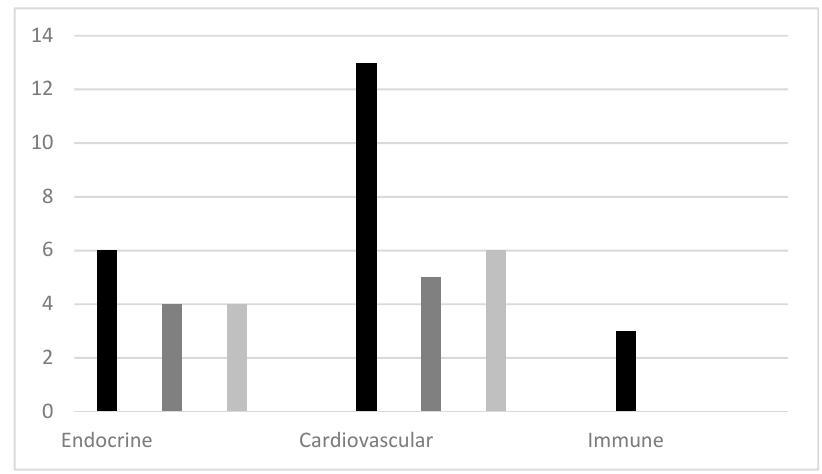
Figure 2. Synthesis of psychological outcomes of nature-based interventions.